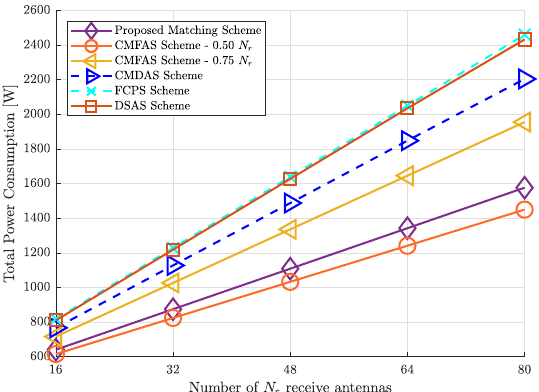
Figure 4. Total power consumption versus number N r of antennas, where M = 80 APs, N Q = 8, ρ = 23 dBm, and K = 8